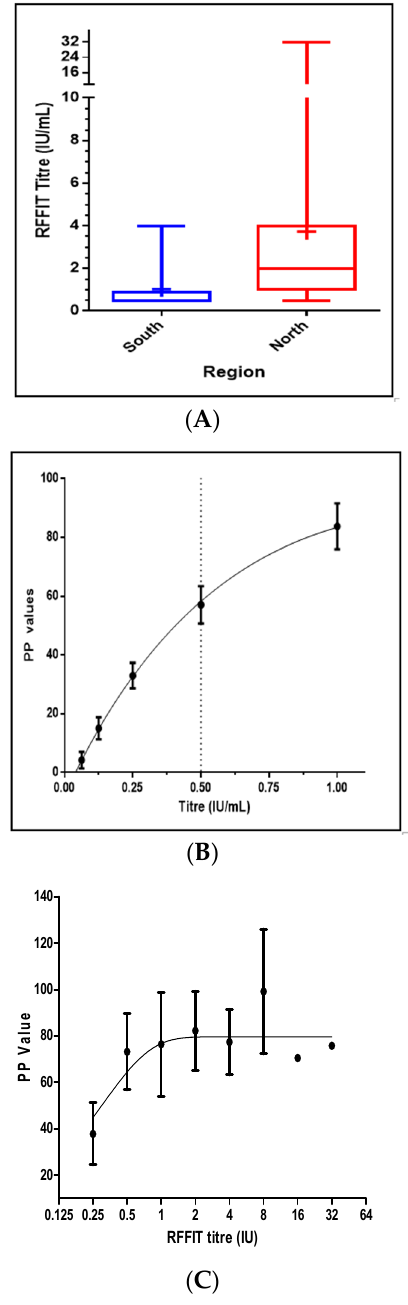
Figure 2. Tukey Box and Whisker Plot for region-wise rabies virus neutralizing antibody (VNA) titres in vaccinated dogs ( A ) and graph showing rabies VNA titre versus percent positivity (PP) values of control sera ( B ). Nonlinear regression plot depicting the percent positivity (PP) values with standard deviation of tested samples against the corresponding RFFIT VNA titre ( C ).